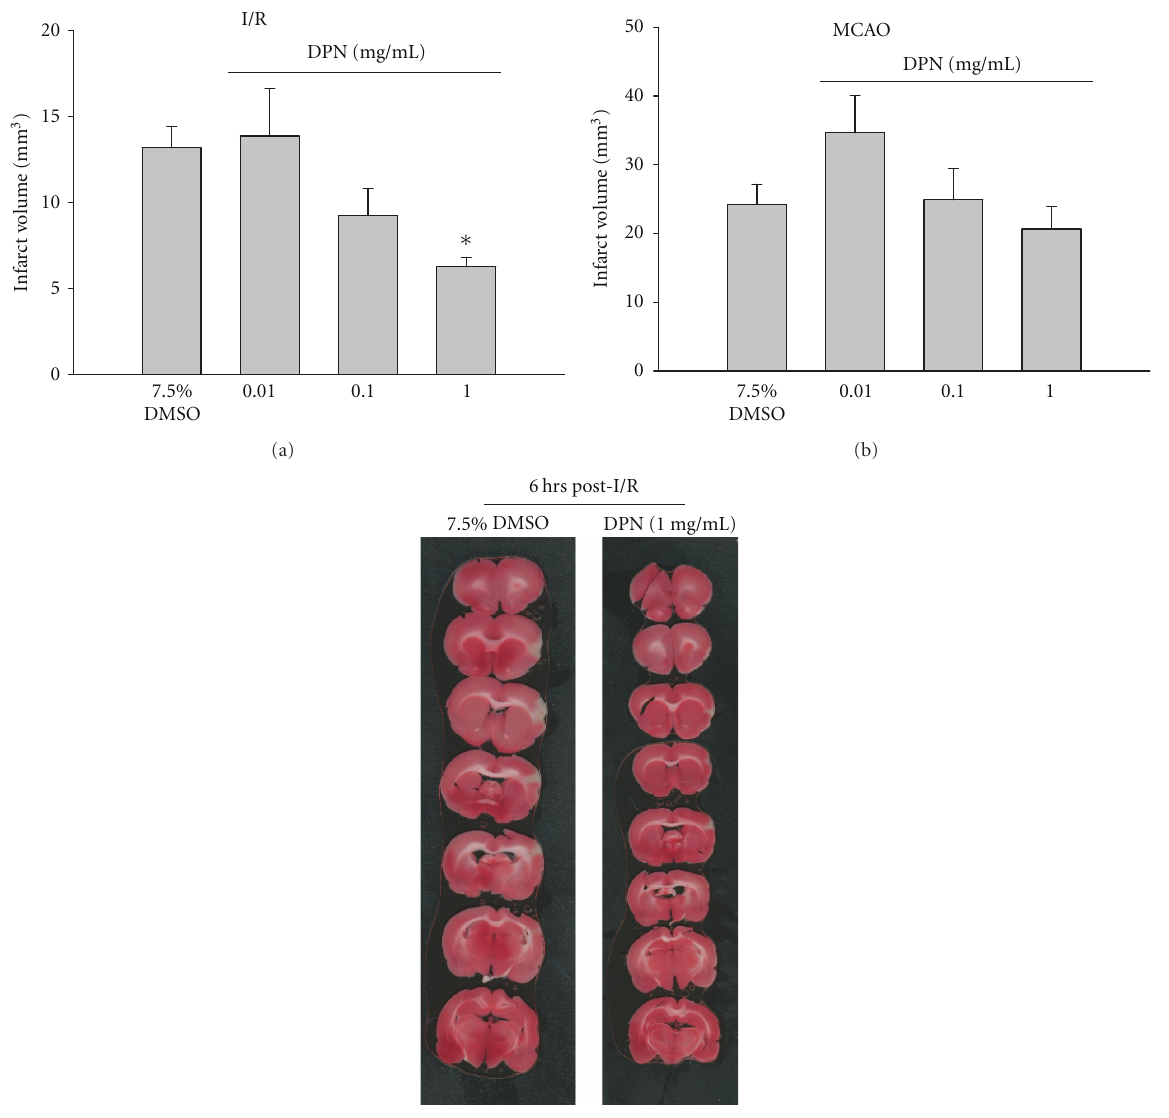
Figure 2: E ff ect of pretreatment with either 7.5% DMSO or DPN (i.v.; 30 minutes) on infarct volume (mm 3 ) calculated from TTC-stained 1mm thick coronal sections throughout the extent of the infarct following I/R (a) and MCAO (b). Each bar represents the mean ± S.E.M ( n = 4–6/group), and ∗ indicates significance ( P ≤ . 05) from the DMSO control group. (c) Representative photomicrographs of TTC stained, 1mm thick coronal slices illustrating the extent of the infarct within the prefrontal cortex following 30 minutes pretreatment (i.v.) with either DMSO or DPN (1mg/kg) at 6 hours